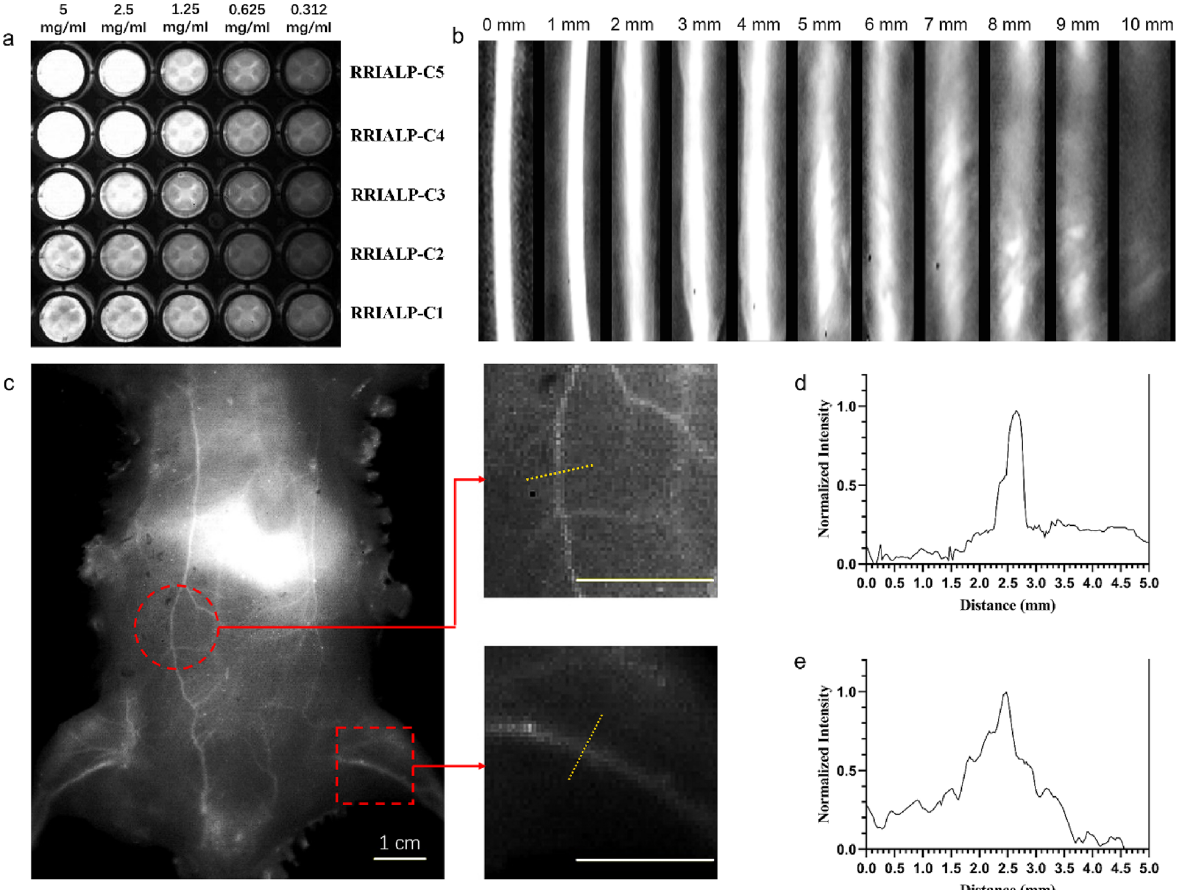
Fig. 6 NIR-II FI properties of RRIALP-C4. a The NIR-II fluorescence signals of liposomes at different phospholipid concentrations. b The NIR-II fluorescence signals of liposomes are covered by different thicknesses of chicken tissues. c Systemic angiography of the Balb/c mice body after intravenous injection with RRIALP-C4 under 1064 nm laser excitation (1064 nm LP and 1064 nm OD filters). d , e Fluorescence intensity analysis of abdomen and hind limb